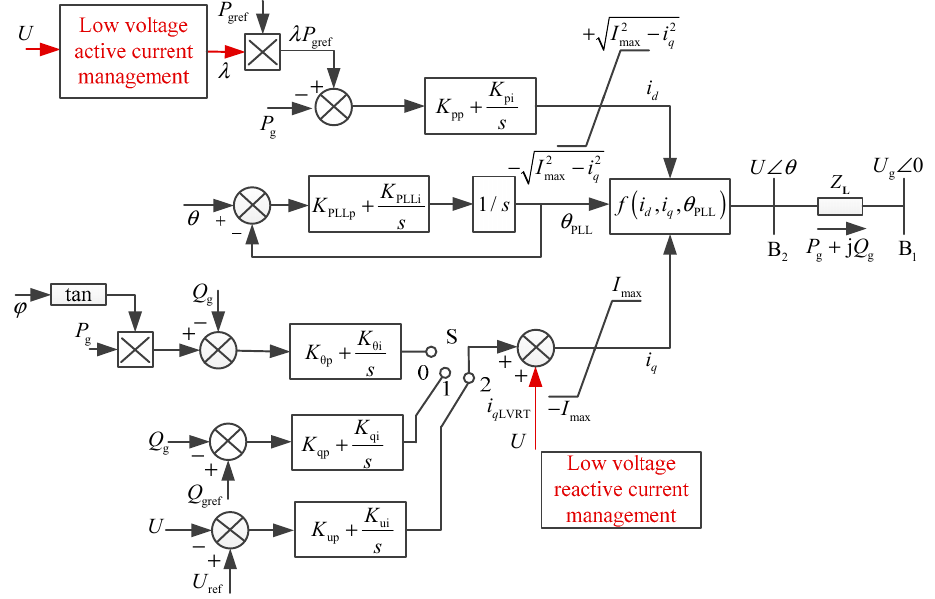
Figure 4. The general renewable DG model.